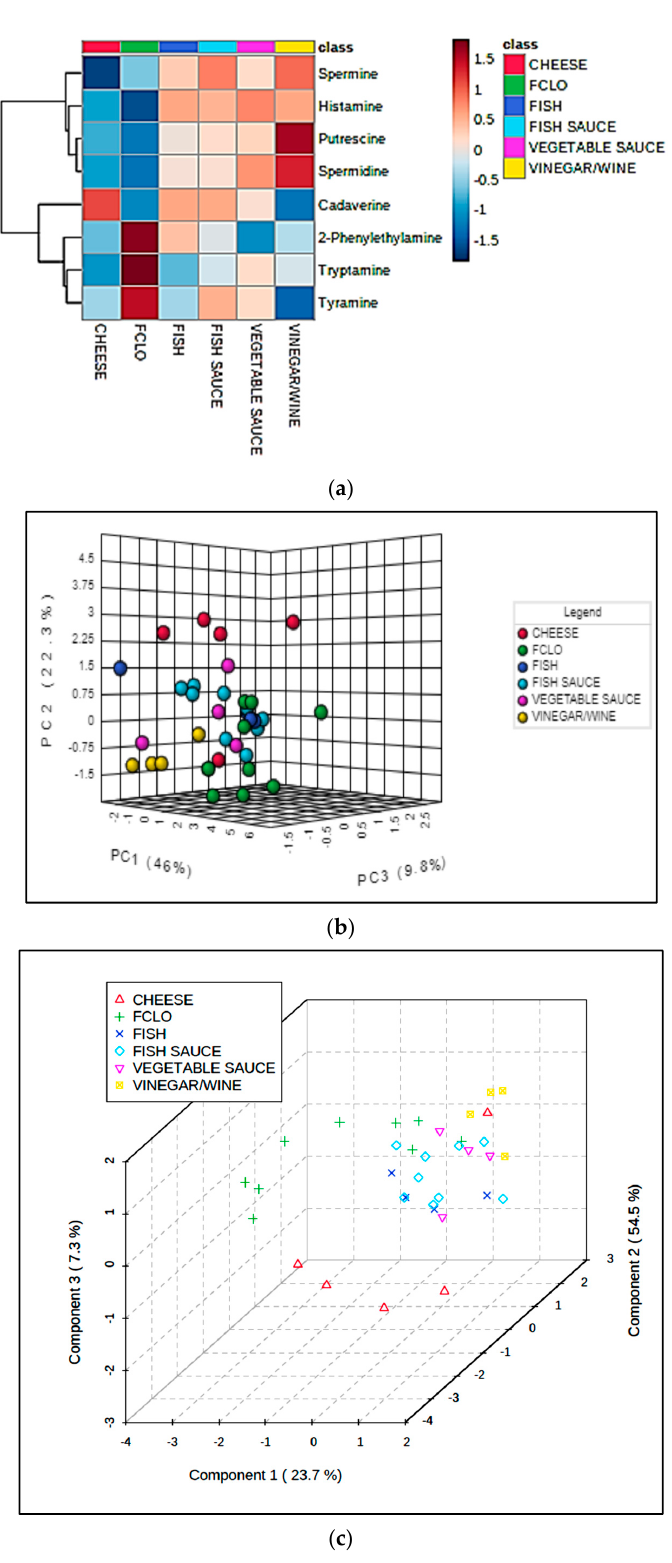
Figure 5. ( a ) Heatmap diagram displaying the most univariately-significant differences between mean values of eight BA explanatory variables (near right-hand side y -axis) for the fermented cheese (red), FCLO (green), fish (dark blue), fish sauce / paste (pale blue), vegetable sauce (purple), and wine / vinegar (yellow) products. The complete BA dataset was CS-normalized, glog-transformed, and